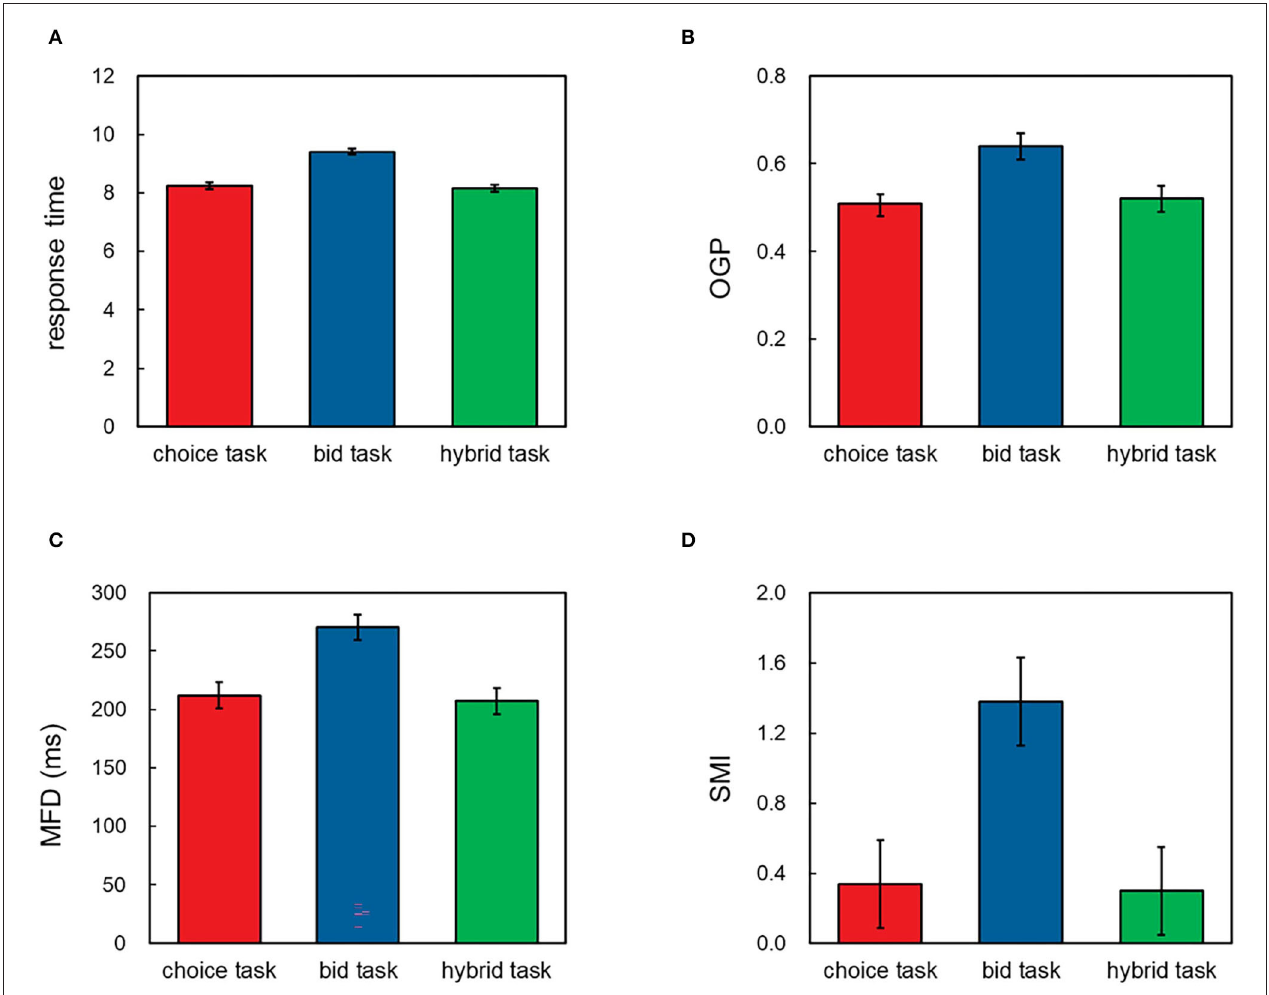
FIGURE 3 | Results of (A) response time, (B) OGP, (C) MFD, and (D) SMI in the experiment. Error bars represent 95%